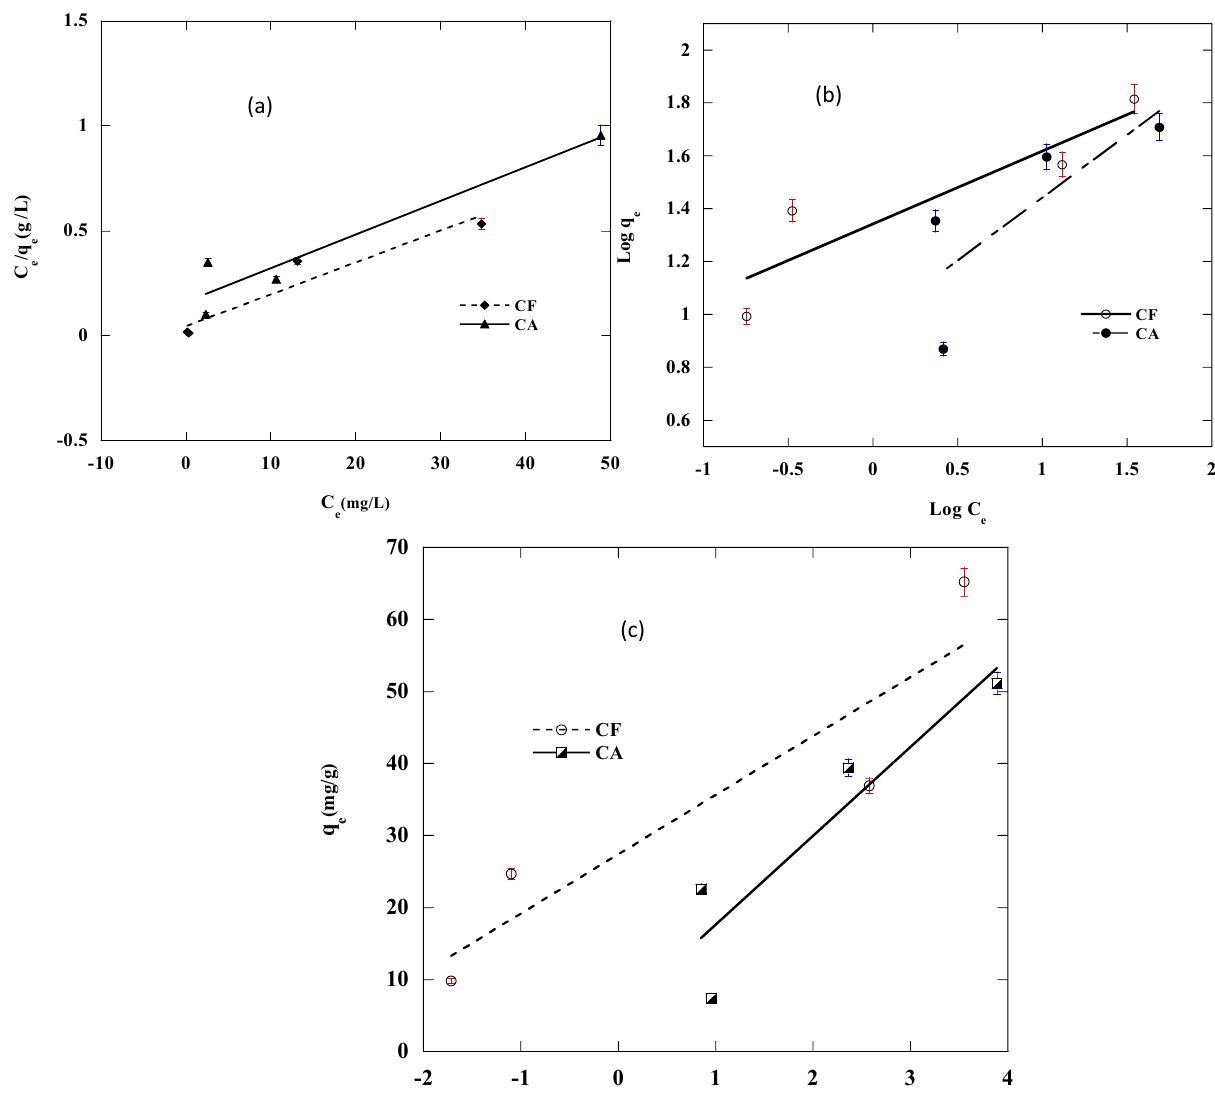
Figure 9. Adsorption isotherms for the adsorption of Disperse red 60 dye by 50 mg of CF and CA at 20 °C and pH 6: ( a ) Langmuir isotherm, (b) Freundlich isotherm, ( c ) Tempkin isotherm.